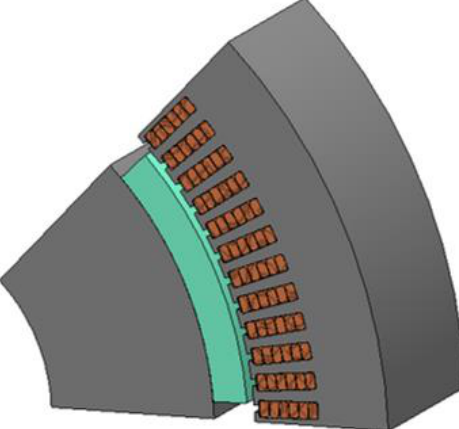
Figure 2. The geometry of the optimal motor from [12]. Table 1. Comparison between the motor with random windings and the motor with hairpin wind- ings [12].